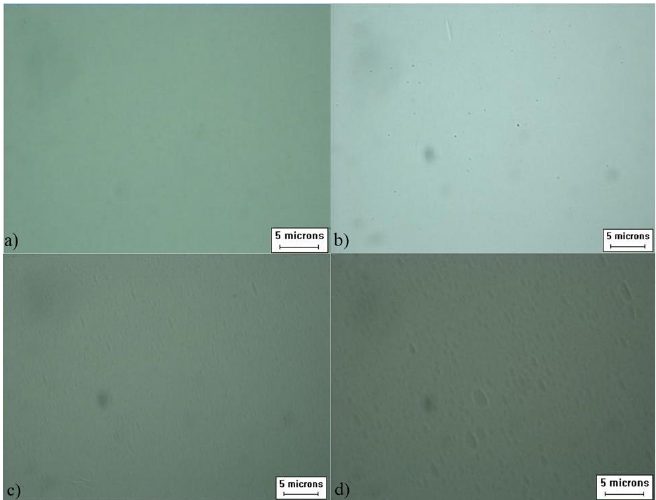
Figure 4. Comparison of the morphology of wafers etched in etching solutions with different water